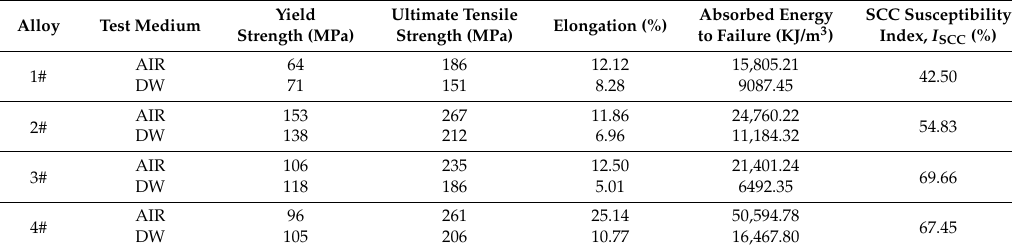
Table 1. Mechanical properties and stress corrosion cracking (SCC) indices for the studied